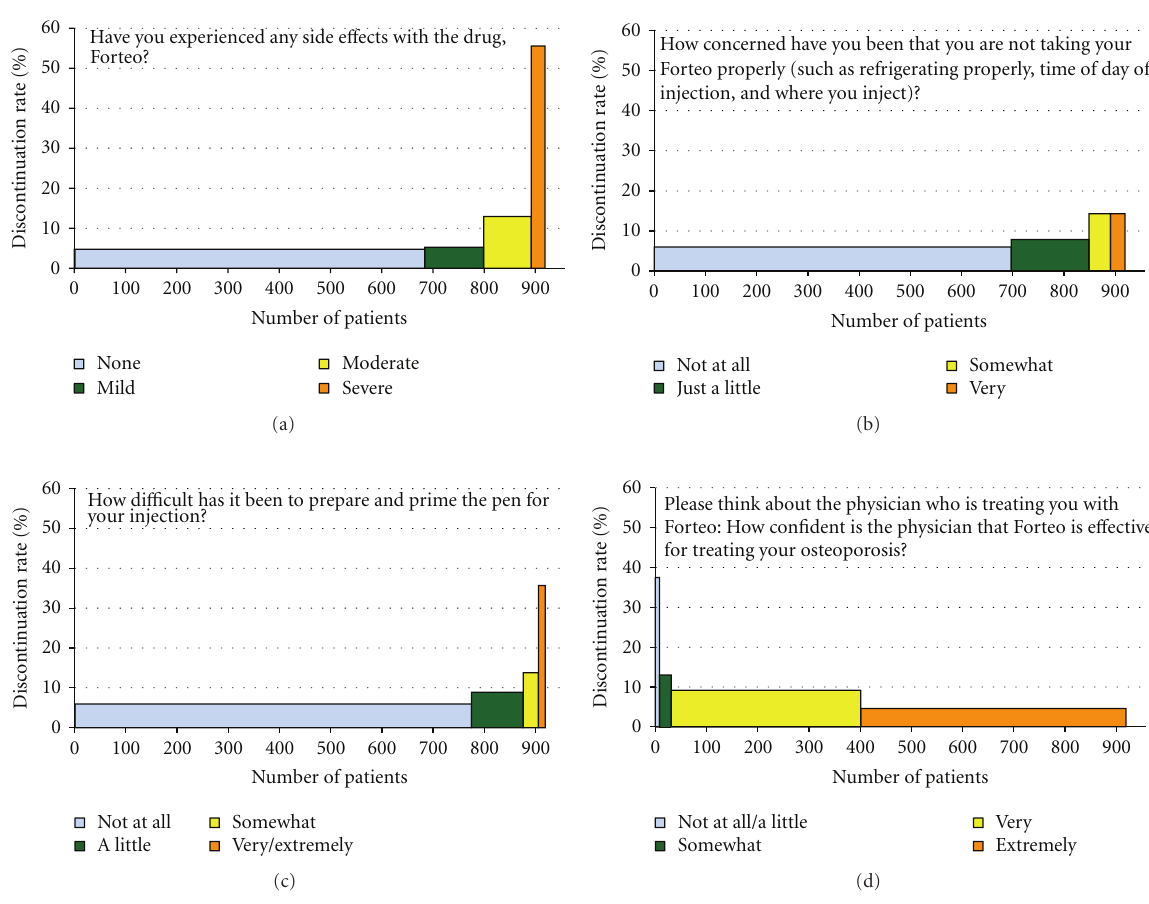
Figure 2: Responses to QF1 significantly associated with early discontinuation (Cochran-Armitage trend test). Additional significant associations, which had trends similar to the questions shown, included: How di ffi cult has it been to: set the dose? inject yourself? clean and store the pen? Other? Overall, how di ffi cult has it been to use Forteo as prescribed? Please think about the physician who is treating you with Forteo: How enthusiastic is the physician about treatment with Forteo? How knowledgeable is the physician about treatment with